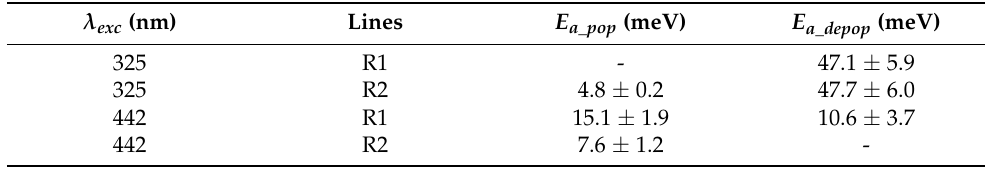
Table 3. Activation energies obtained for the population/depopulation processes of R1- and R2-lines excited either with 325 nm or 442 nm.